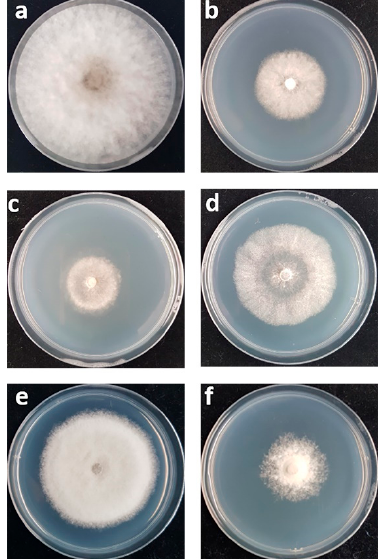
Figure 2. ( a ) Growth on PDA at 25 °C of L. theobromae alone and ( b ) with T. indica DMKU-RP31; ( c ) T. indica DMKU-RP35; ( d ) Ps. hubeiensis YE-21 for three days; ( e ) growth of C. gloeosporiodes alone and ( f ) dual cultivation with P. aspenensis DMKU-SP67 for 14 days by double plates cultivation to determine antifungal volatile organic compounds (VOCs) production. Microorganisms 2020 , 8 , 317